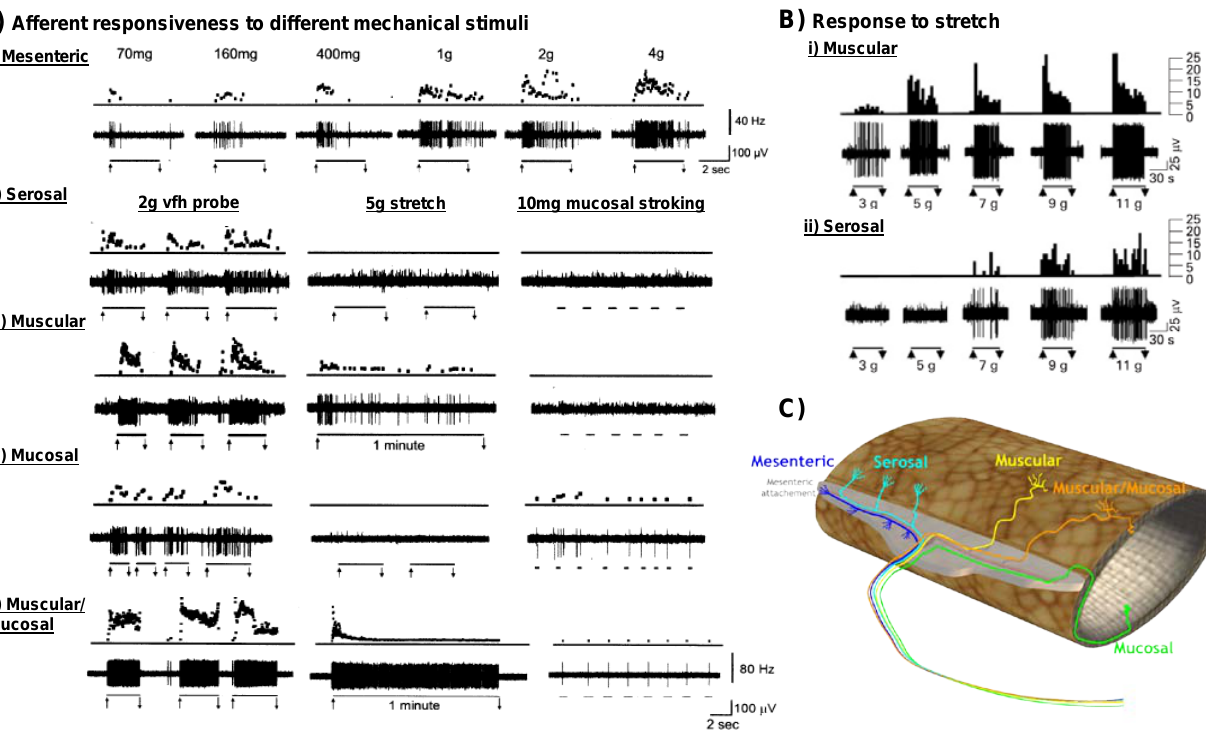
Figure 1. Five classes of mechanosensitive afferent innervate the murine gut. ( A ). Afferents are classified by their responsiveness to distinct mechanical stimuli, circular stretch, fine mucosal stroking and focal compression with calibrated von Frey hairs (vfh): ( A i ) Mesenteric and ( A ii ) serosal afferents respond in a graded manner to focal compression with probes and high intensity stretch (≥7 g; see ( B ii )) or distension (>35 mmHg; not shown). They do not respond to low intensity mucosal stroking (10 mg; see A ( B ii )) or low intensity circular stretch (≤5 g; also see ( B ii )); ( B iii ). Muscular afferents (or tension sensitive afferents as they are called in the upper gut) respond to low intensity circular stretch (<3 g; also see ( B i )) but not fine mucosal stroking; ( B iv ). Mucosal afferents have the lowest mechanical activation thresholds of all afferent classes, responding to fine mucosal stroking (10 mg von Frey hair), but do not respond to circular stretch; ( B v ). Muscular/mucosal afferents display the properties of muscular and mucosal afferents as they respond to both low intensity stretch and fine mucosal stroking. Overall, muscular, mucosal and muscular/mucosal afferents have low-thresholds for mechanical activation via stretch or stroking respectively, whilst serosal and mesenteric afferents have high-thresholds for mechanical activation by stretch; ( C ). Graphical representation of the 5 different subtypes of afferent innervating the mouse colorectum. ( A ) Modified from Brierley et al. [31] with permission; ( B ) Modified from Hughes et al. [37] with permission; ( C ) Modified from Brierley [18] with